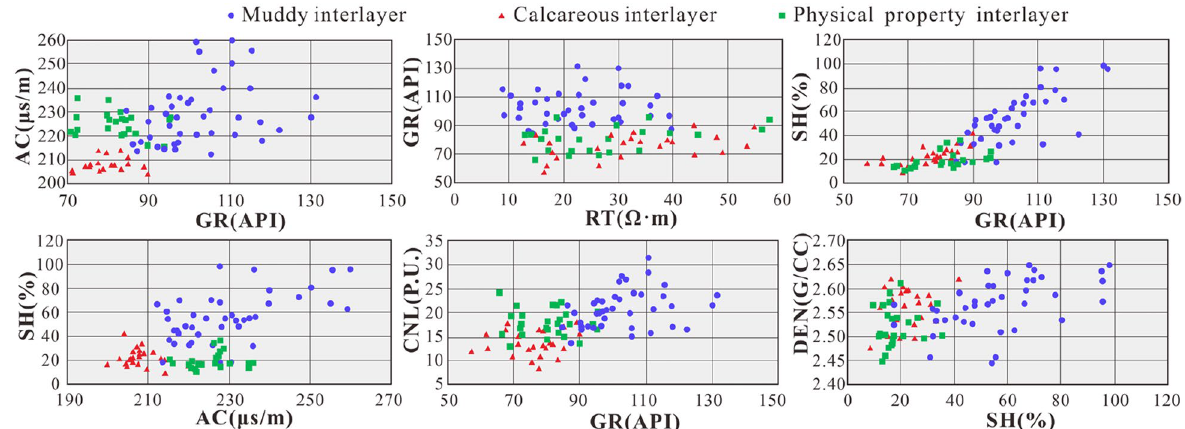
Figure 11. Intersection chart of electrical measurement curves of architectural interfaces between various facies.